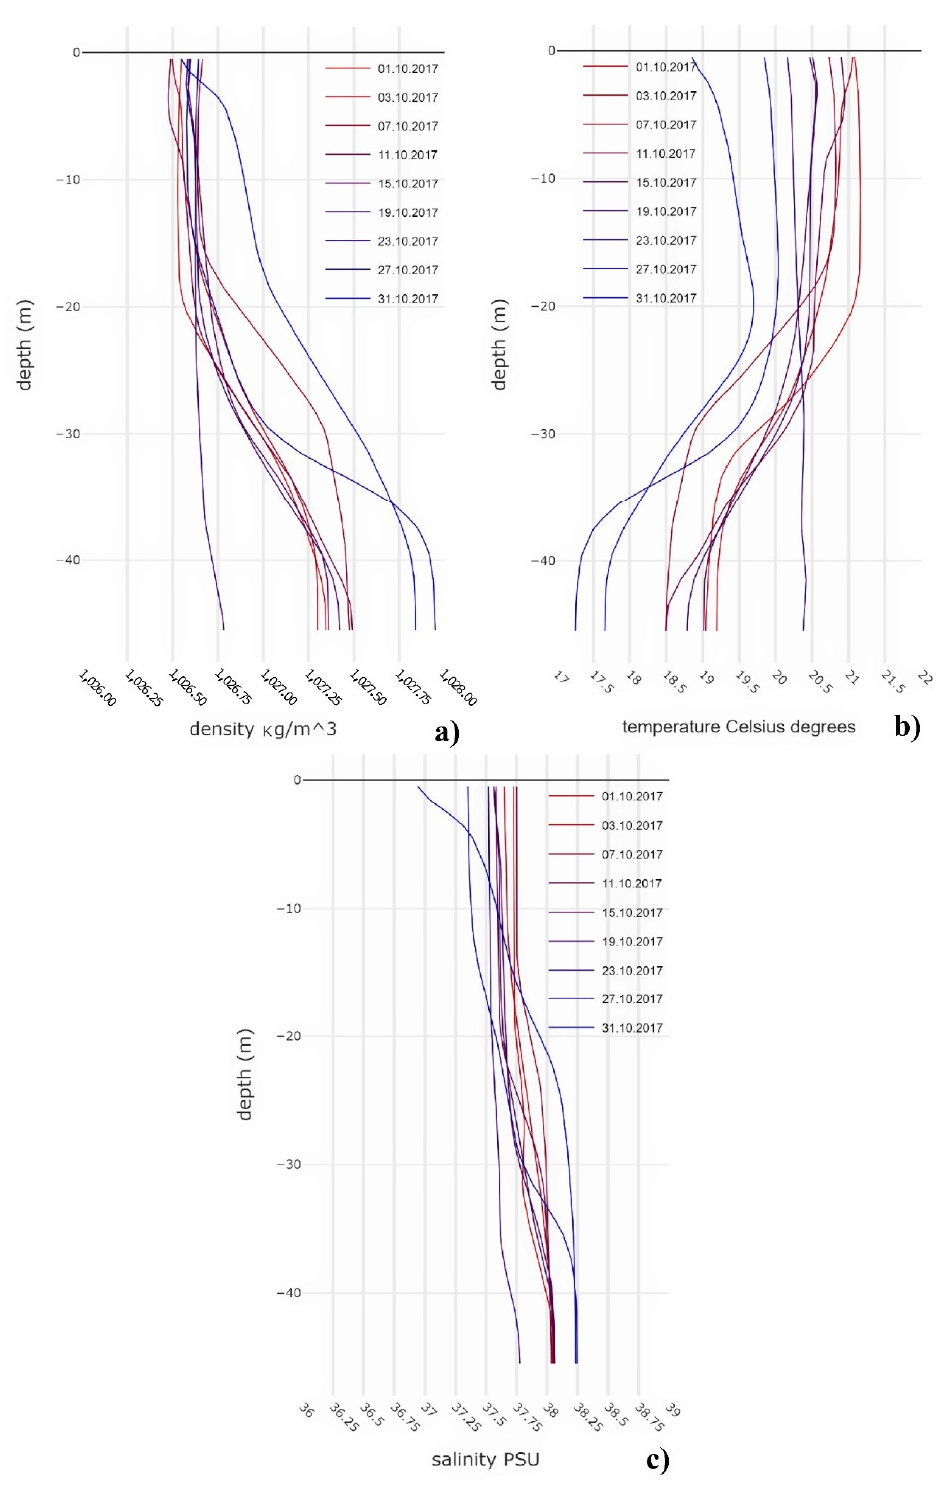
Figure 7. ( a ) Salinity, ( b ) temperature, and ( c ) density profiles computed by MIKE 3 HD for the simulation period 1–31 October 2017, for Plt B site.